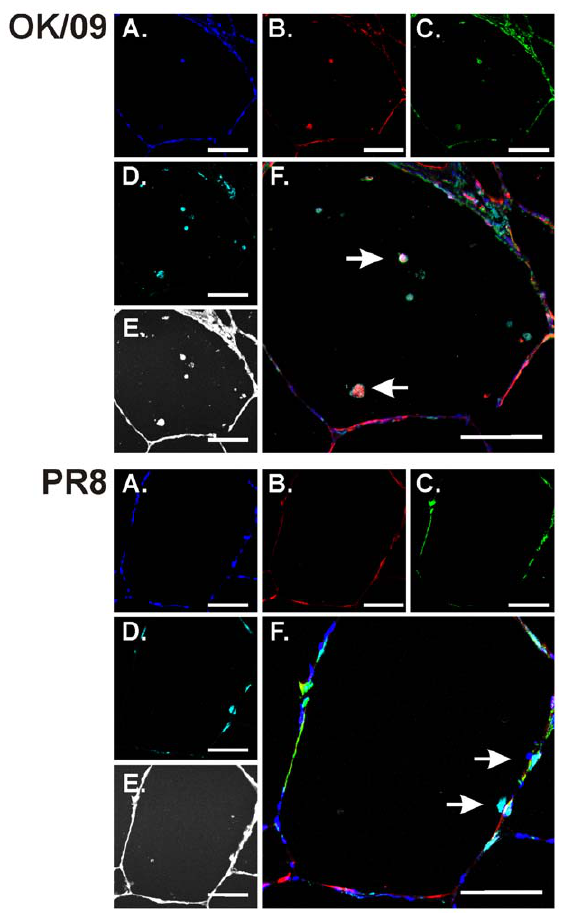
Figure 7. Infectivity of influenza virus and IP-10 induction in macrophages in human lung. Lung slices were exposed to 6 6 10 6 PFU/ml of influenza virus PR8 or OK/09 or virus diluents for 24 h in the presence of brefeldin A (BFA) to enhance the detection of cytokines. Slices were then processed for immunohistochemistry for the detection of the chemokine IP-10 using goat polyclonal antibodies, viral nucleoprotein (NP) using rabbit polyclonal antibody, and macrophages using anti-CD68 monoclonal antibody. Nuclei were stained with SYTOX green. Top : OK/09. Bottom : PR8. A–D : fluorescent images that demonstrate nuclei ( A ; blue), NP ( B ; red), IP-10 ( C ; green), and macrophages ( D ; cyan). E : bright-field images that demonstrate that lung architecture is preserved during the experiment. F : overlays of the fluorescent images that demonstrate that influenza induces IP-10 in CD68 positive intraalveolar cells, likely alveolar macrophages (arrows). Bars=100 m m.